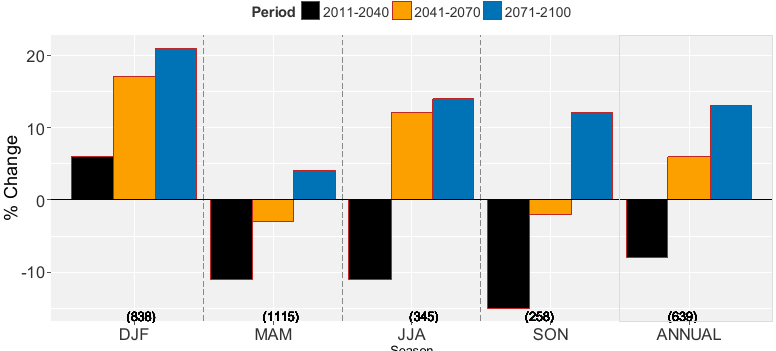
Figure 7. Seasonal flow changes. The seasons are defined as December–February as DJF, March–May as MAM, June–August as JJA and September–November as SON. The figures in brackets at the lower part of the plot (in black) are the average observed seasonal flows in m 3 /s. The changes (bar graph) are expressed as percentage (%) of the current seasonal flows.